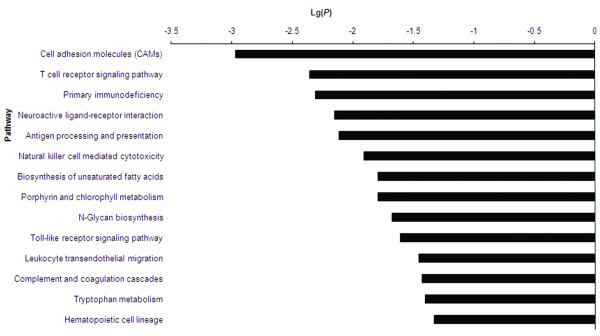
Signaling pathways of DE genes. Pathway analysis was predominantly based on the KEGG database. A P-value of < 0.05 and an FDR of < 0.05 in the two-sided Fisher's exact test were classed as significant. The vertical axis represents the pathway category and the horizontal axis represents the log10 (p value) of these significant pathways.